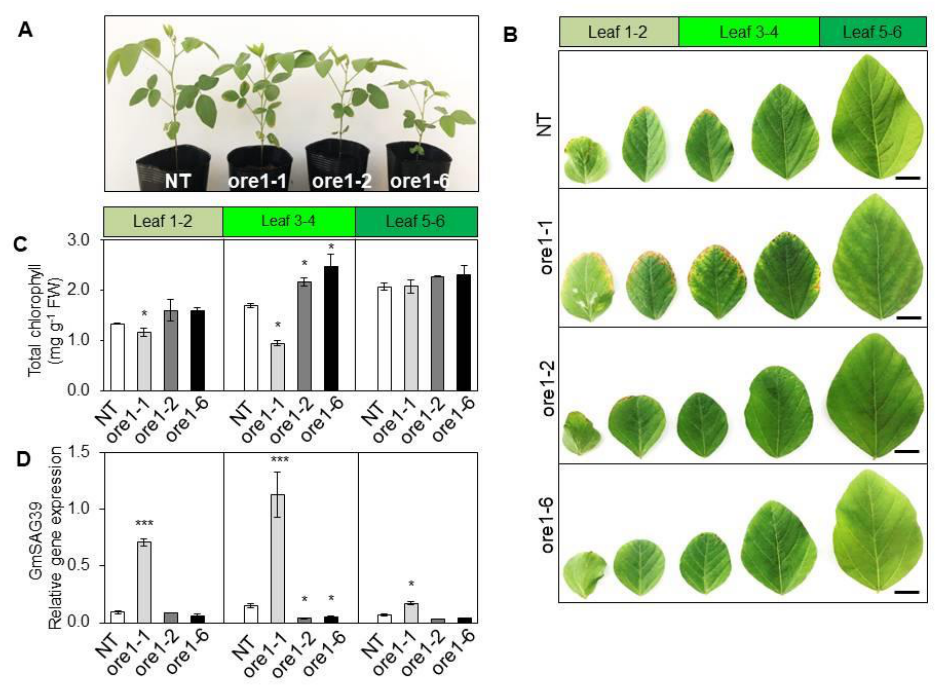
Figure 1. Comparison of the phenotype of ore1 soybean transgenic and wild-type (NT) plants at V3- vegetative stages. ( A ) Representative pictures showing plant architecture of 30-day-old T2-generation ore1 -1, ore1 -2, ore1 -6 transgenic lines, and NT at the V3 stage under controlled growth conditions. ( B ) Fully expanded leaf phenotype visualizations, respectively, bar 1 cm. The leaves were collected from older leaves (leaf No. 1–2), middle leaves (leaf No. 3–4), and young leaves (leaf No. 5). ( C ) Total chlorophyll content in the leaves. ( D ) Soybean senescence-associated gene 39 ( GmSAG39 ) is expressed in leaves in wild-type and transgenic plants. Asterisks indicate significant differences from NT and transgenic plants according to Tukey’s t -test; * p < 0.05, *** p < 0.001.